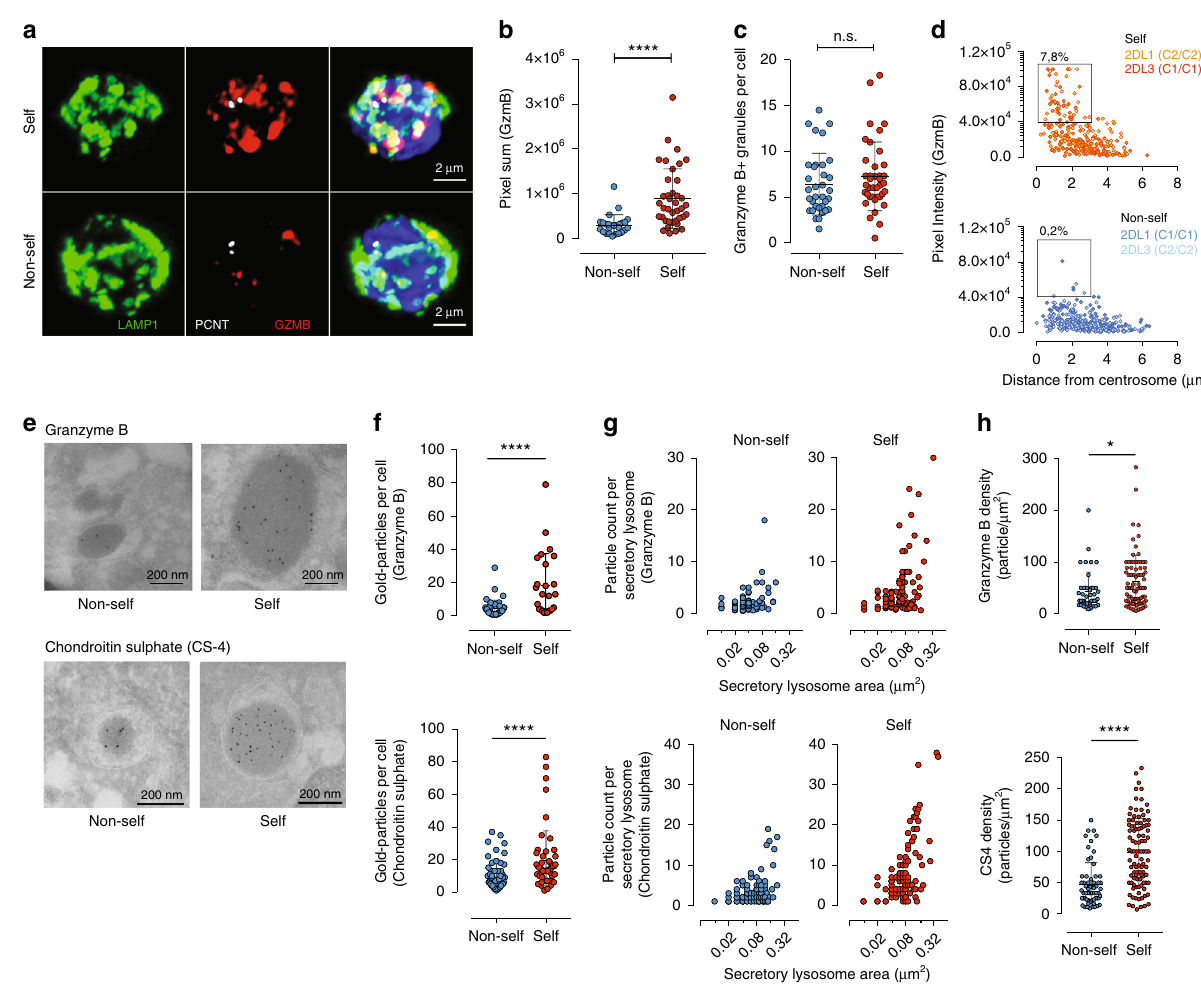
Fig. 3 Modulation of the lysosomal compartment in educated NK cells. a Confocal microscopy Z-stack showing Pericentrin (PCNT), LAMP-1, and granzyme B (GZMB) staining in sorted mature CD56 dim NKG2A − NKG2C − CD57 − NK cells expressing non-self or self KIR. Scale bar is 2 μ m. b The pixel sum of granzyme B staining in cells expressing non-self or self KIR. c The number of LAMP-1 + lysosomal structures. Data in panels ( b ) and ( c ) are aggregated from sorted 2DL1 and 2DL3 single-positive NK cell subsets from C1C1 ( n = 5 donors) and C2C2 ( n = 5 donors) donors. d Granzyme B expression levels versus the distance from the centrosome in individual lysosomes in sorted NKG2A − NKG2C − CD57 − NK cells expressing non-self or self KIR ( n = 804 lysosomes from 3 donors were analyzed). Gates were set based on visual inspection to quantify the percentage of granzyme-B dense secretory lysosomes in self and non-self NK cells. e Representative immuno-EM section showing staining with gold-particle coated anti-granzyme B (top) and Chondroitin Sulphate-4 (CS-4) (bottom) of sorted CD56 dim NKG2A − NKG2C − CD57 − NK cells expressing non-self or self KIR. Scale bar is 200 nm. f Number of gold particles (granzyme B and CS-4) per cell. (non-self n = 83 cells, self n = 109 cells). g Particle count (granzyme B and CS-4) as a function of the lysosomal area. h Density of gold particles (granzyme B and CS-4) per lysosomal area ( μ m 2 ). Immuno-EM data are from 5 donors and 5 experiments. Paired t -tests were performed in panels ( b , c , e , and g ). **** p < 0.0001 and * p < 0.05. Red and blue circles and box plots represent NK cells with self or non-self